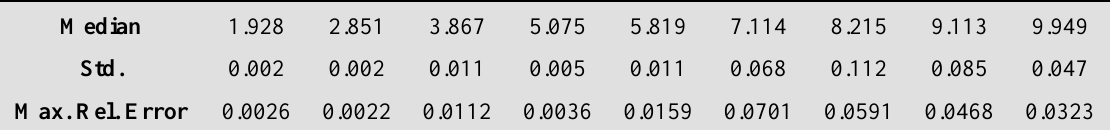
Table 1. Results of measurement of distances between the sensor and a parked